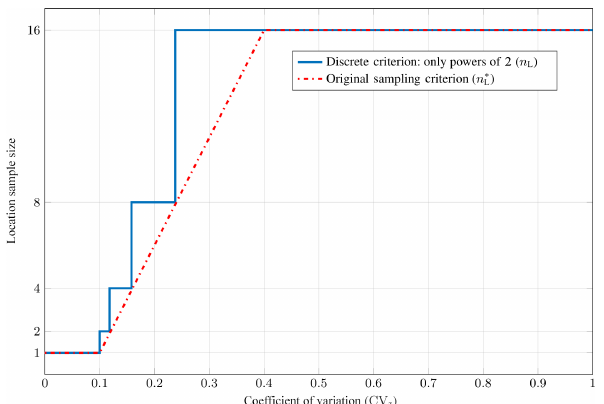
Figure 9. Criterion II.a: number of samples per zone depending on the number of risk items in the portfolio. Note that we do not round up to the next higher power of 2, since this plot illustrates Eq. (14), which is an intermediate